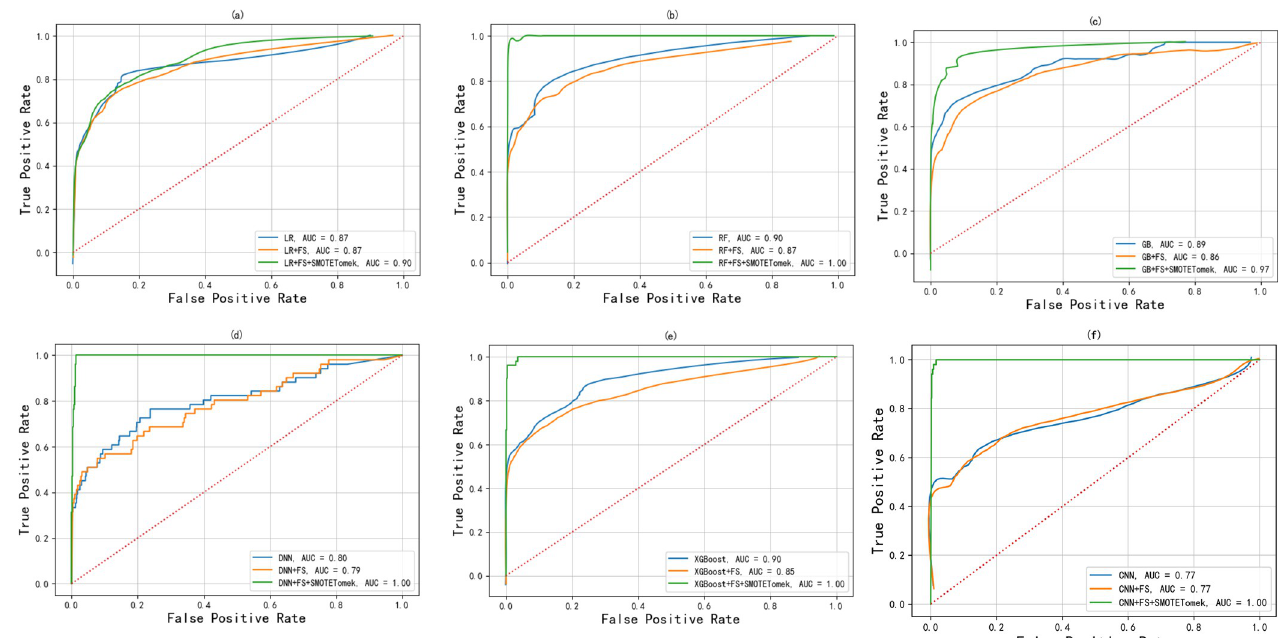
Fig 6. ROC curves of the model under non-feature selection, feature selection, and mixed sampling.